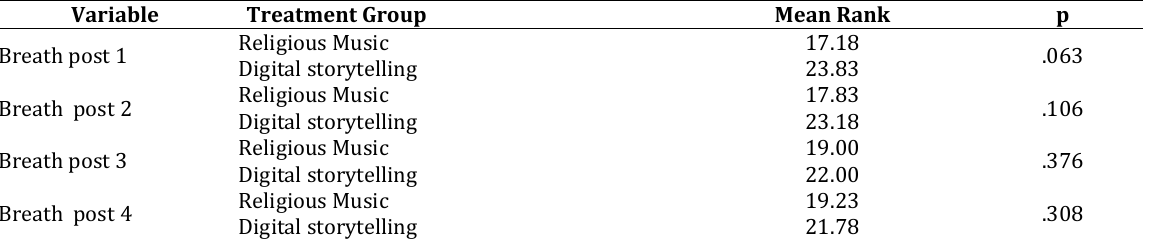
Table 10 Mann Whitney Test Results of The Effectiveness of Religious Music and Digital Storytelling on the Breath Frequency of